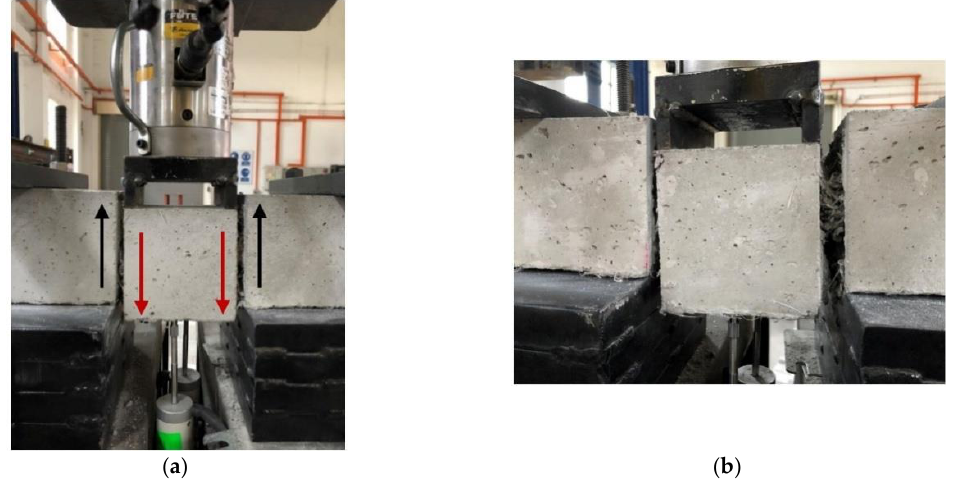
Figure 8 . Experimental photos showing the ( a ) in-plane shear (mode II fracture) failure and ( b ) specimen instability due to higher fiber count on the right-hand side of the prism.